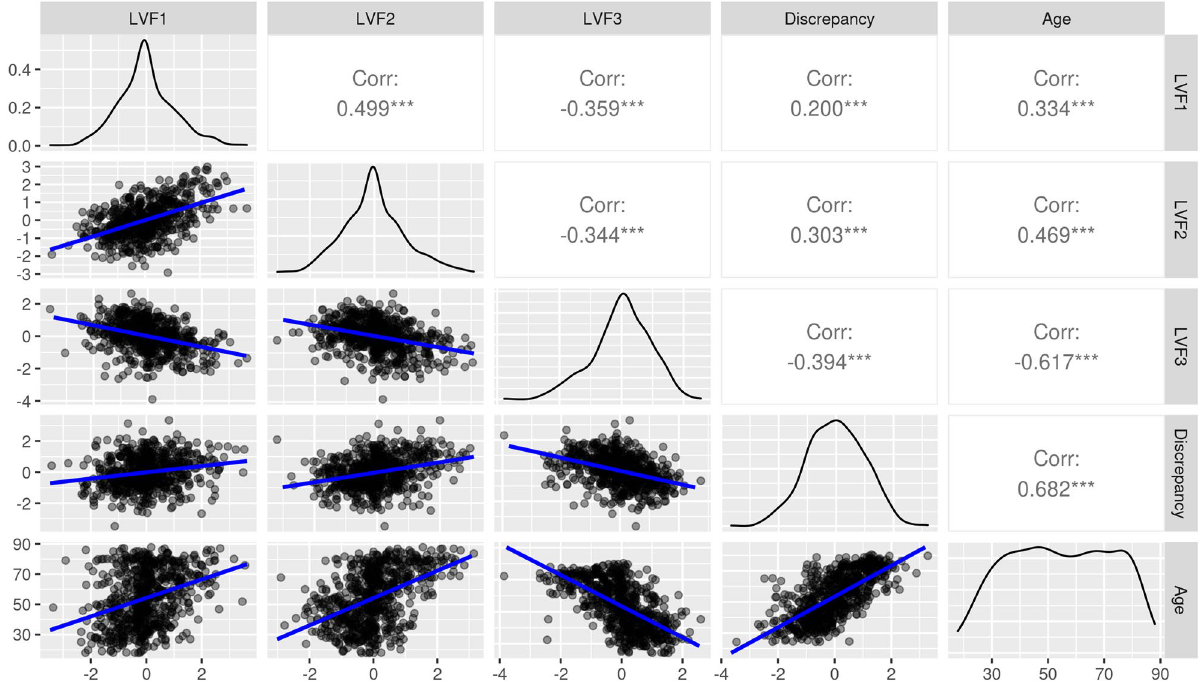
Figure 3. Scatter plots (lower left), distributions (leading diagonal) and Pearson correlations (upper right) for latent vascular factors, ability discrepancy and age. Scatter plots show linear associations (blue) and data intensity (greyscale). Stars indicate increasing significance on the correlations: ***, p < 0.001; **, p < 0.01; *, p < 0.05. Corr correlation coefficient, Discrepancy ability discrepancy, LVF1-3 latent vascular factors